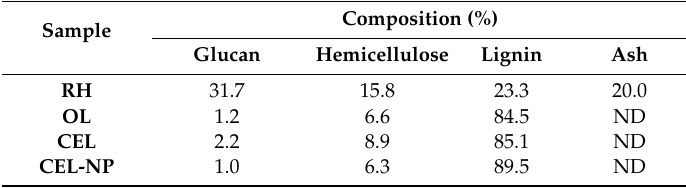
Table 1. Chemical composition of rice husks and prepared